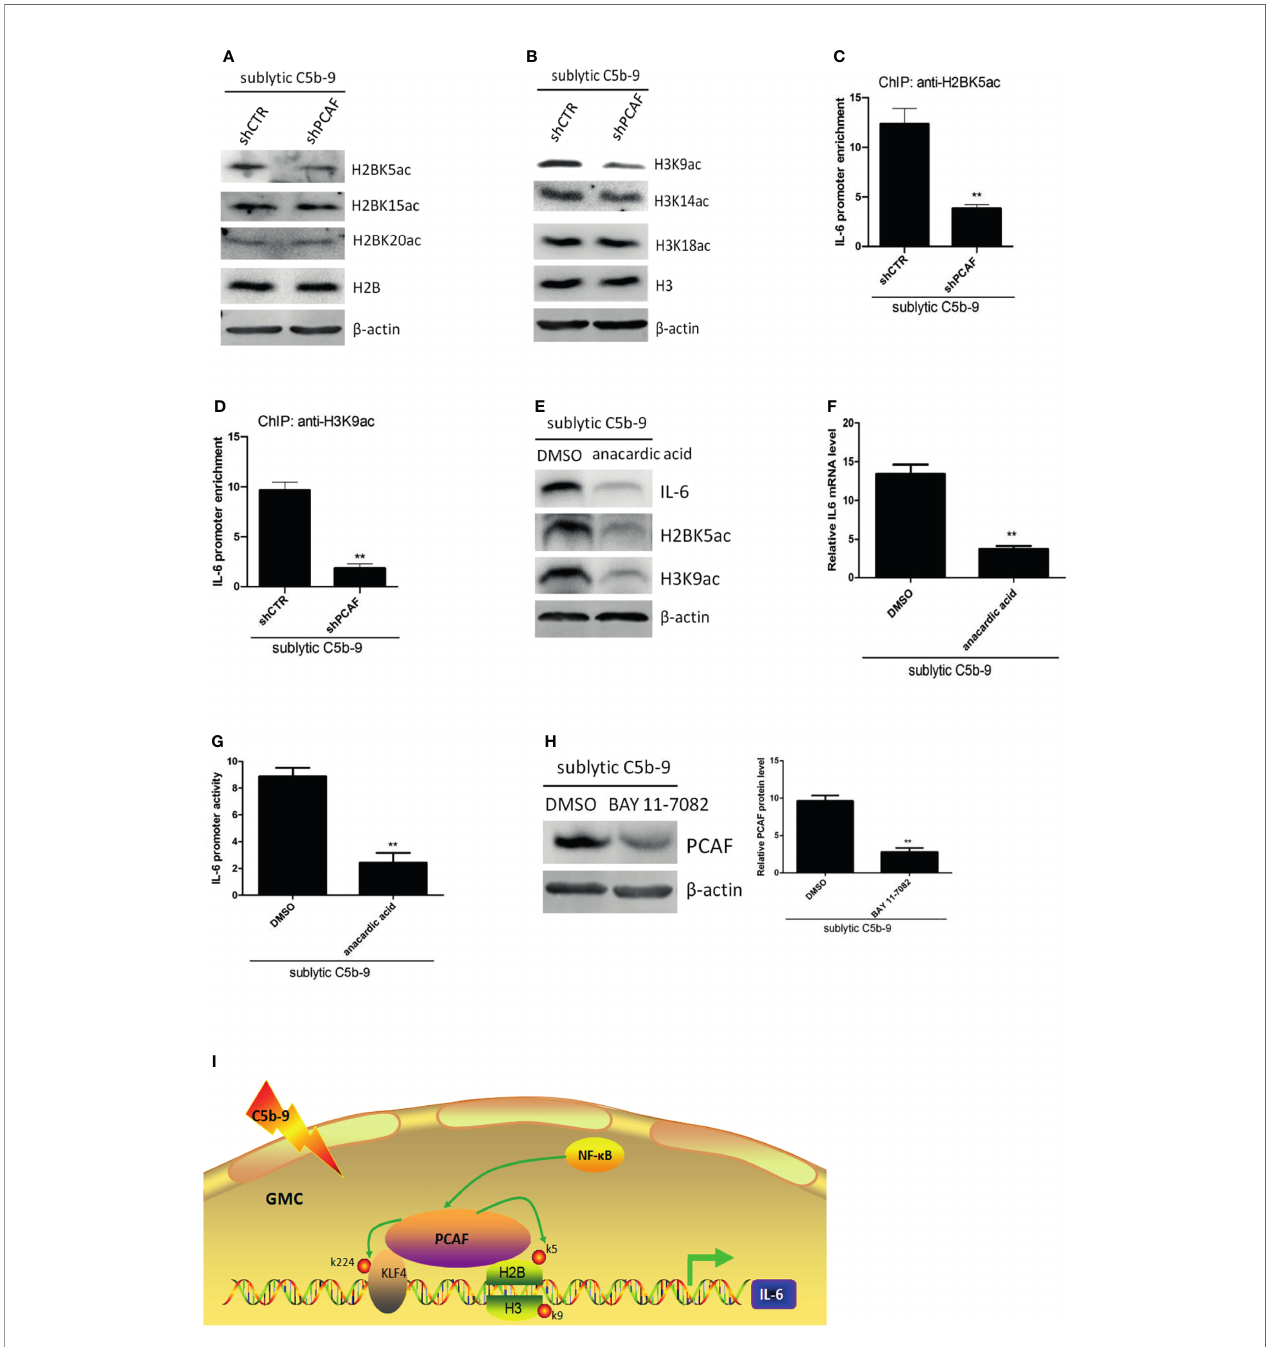
FIGURE 6 | Effect of histone acetylation by PCAF on IL-6 gene transcription in GMCs in response to sublytic C5b-9. (A – D) GMCs were transfected with shCTR or shPCAF for 48 h and then incubated with sublytic C5b-9 for 3 h. (A) IB analysis of H2B acetyl K5, H2B acetyl K15, H2B acetyl K20, and H2B. (B) IB analysis of H3 acetyl K9, H3 acetyl K14, H3 acetyl K18, and H3. (C) ChIP – qPCR analysis of enrichment of H2B acetyl K15 on IL-6 promoter ( − 372 to − 166 nt). (D) ChIP – qPCR analysis of enrichment of H3 acetyl K9 on IL-6 promoter ( − 372 to − 166 nt). **p < 0.01 vs. shCTR + sublytic C5b-9. (E – G) GMCs were pretreated with DMSO or anacardic acid (30 m M) for 1 h and then stimulated with sublytic C5b-9 for 3 h. (E) IB analysis of IL-6, H2B acetyl K5, and H3 acetyl K9. (F) qPCR analysis of IL-6. (G) Luciferase activity assay of IL-6 reporter ( − 1,791 to +30 nt). **p < 0.01 vs. DMSO + sublytic C5b-9. (H) GMCs were pretreated with BAY 11-7082 for 30 min and then stimulated with sublytic C5b-9 for 3 h. IB analysis of KLF4 (**p < 0.01 vs. DMSO + sublytic C5b-9). (I) A putative scheme for regulatory mechanisms of IL-6 expression induced by sublytic C5b-9 in GMCs. KLF4 binds to IL-6 promoter and activates its transcription. PCAF acetylates KLF4 (at K224) and neighboring histones H2B (at K5) and H3 (at K9), contributing to IL-6 transcription. Besides, NF- k B signaling pathway also regulates IL-6 expression via increasing PCAF expression. Data are representative of three independent experiments with similar results or are shown as mean ± SD from three independent experiments. GMCs, glomerular mesangial cells; IB, immunoblotting; DMSO, dimethyl